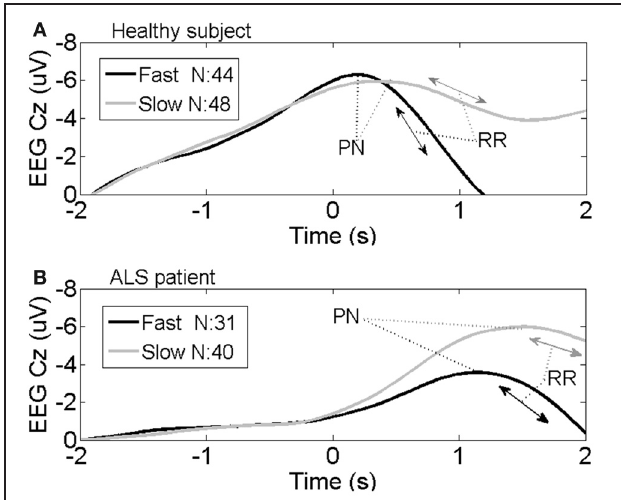
FIGURE 1 | Average MRCP from one representative healthy subject (A) and one representative ALS patient (B) at channel Cz during the fast and slow speed tasks. Imaginary movement onset is represented by time 0s; N , number of averaged trials; PN, Peak Negativity; RR, Rebound Rate.